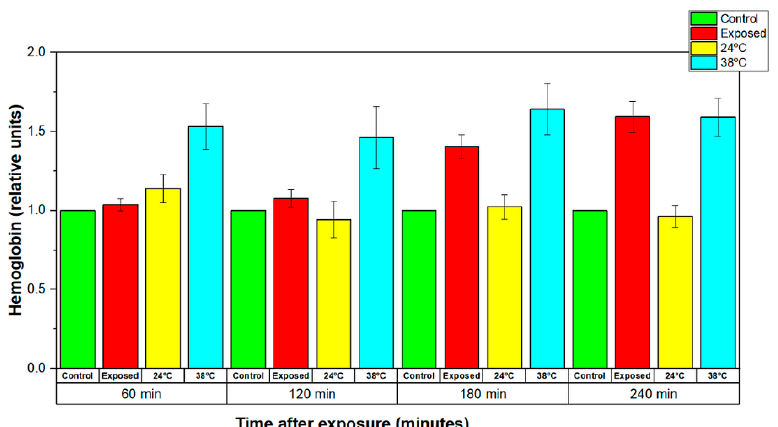
Figure 13. Normalized levels of the hemoglobin released by the control (sham-exposed), conven- tional heat exposed (38 °C) and EMF-exposed erythrocyte suspensions for 60, 120, 180, and 240 min to 2.41 GHz (WSA SAR = 29.6325 W/kg, psSAR1g = 41.13 W/kg, wearable antenna input power 450 mW, Zigbee-like signal). The mean of 4 experiments ± SEM is shown.